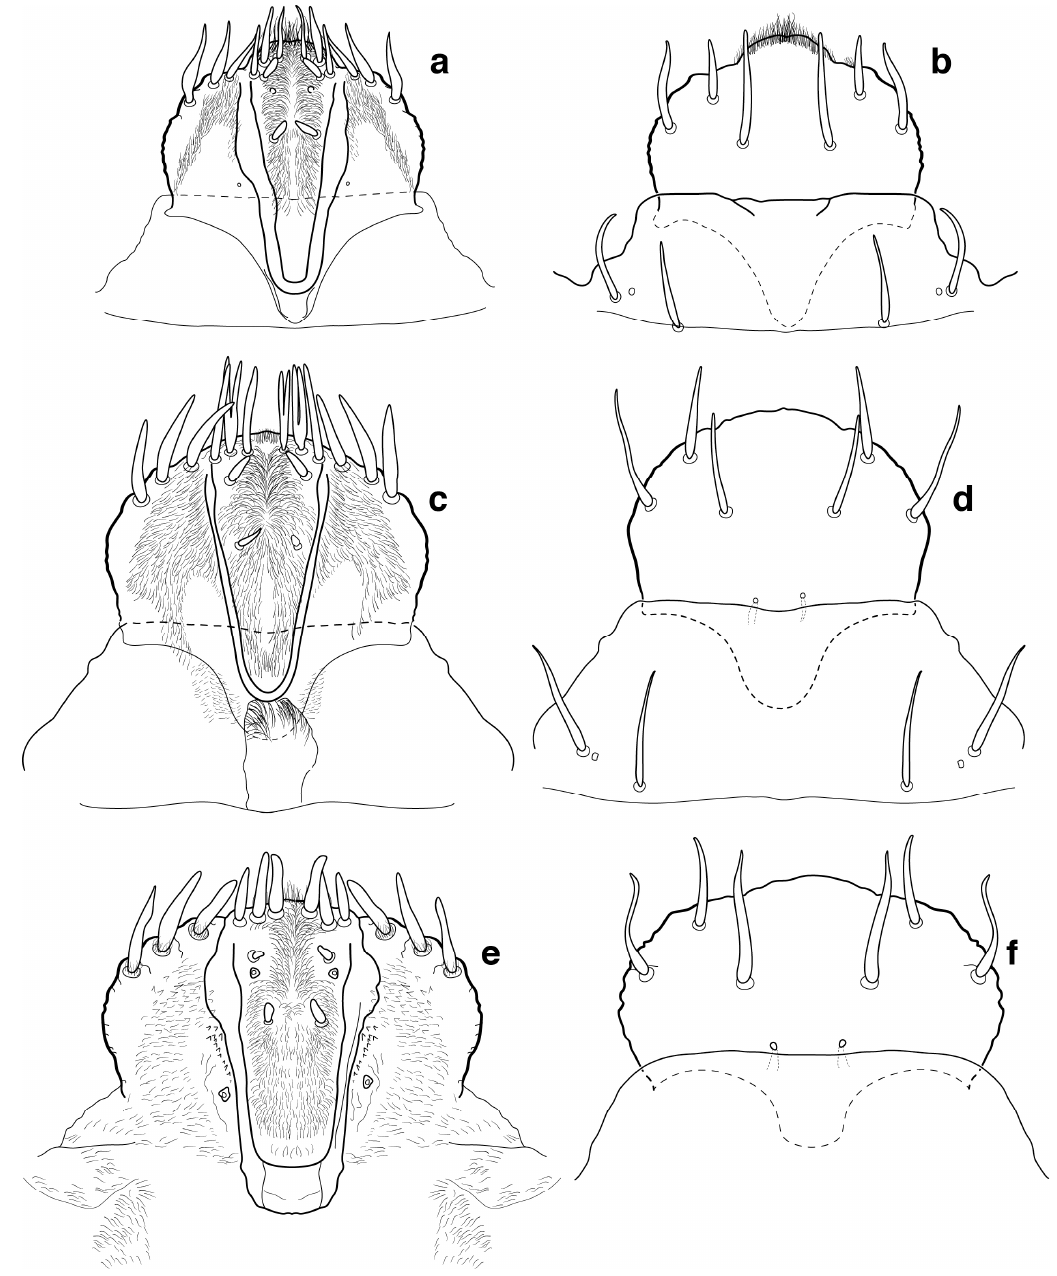
Figure 84. Sphenophorus spp. mouthparts: ( a ) Sphenophorus discolor , epipharynx; ( b ) Sphenophorus discolor ; clypeus and labrum; ( c ) Sphenophorus aequalis , epipharynx; ( d ) Sphenophorus aequalis , clypeus and labrum; ( e ) Sphenophorus maidis , epipharynx; and ( f ) Sphenophorus maidis , clypeus (incomplete) and labrum.